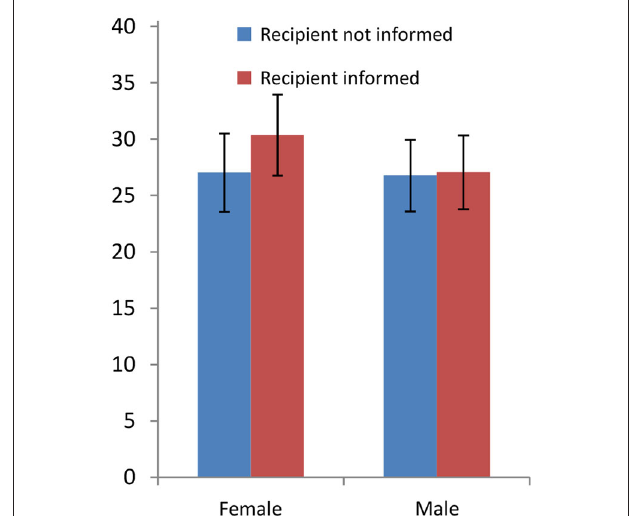
( Friends and Framing vs. Neutral ) confirms no differential treatment effect ( N = 79, p = 0.337).